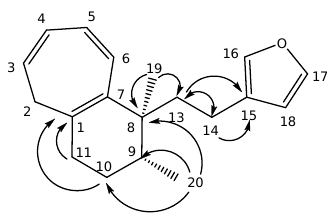
Figure 2. Selected HMBC correlations for compound ( 1 ).